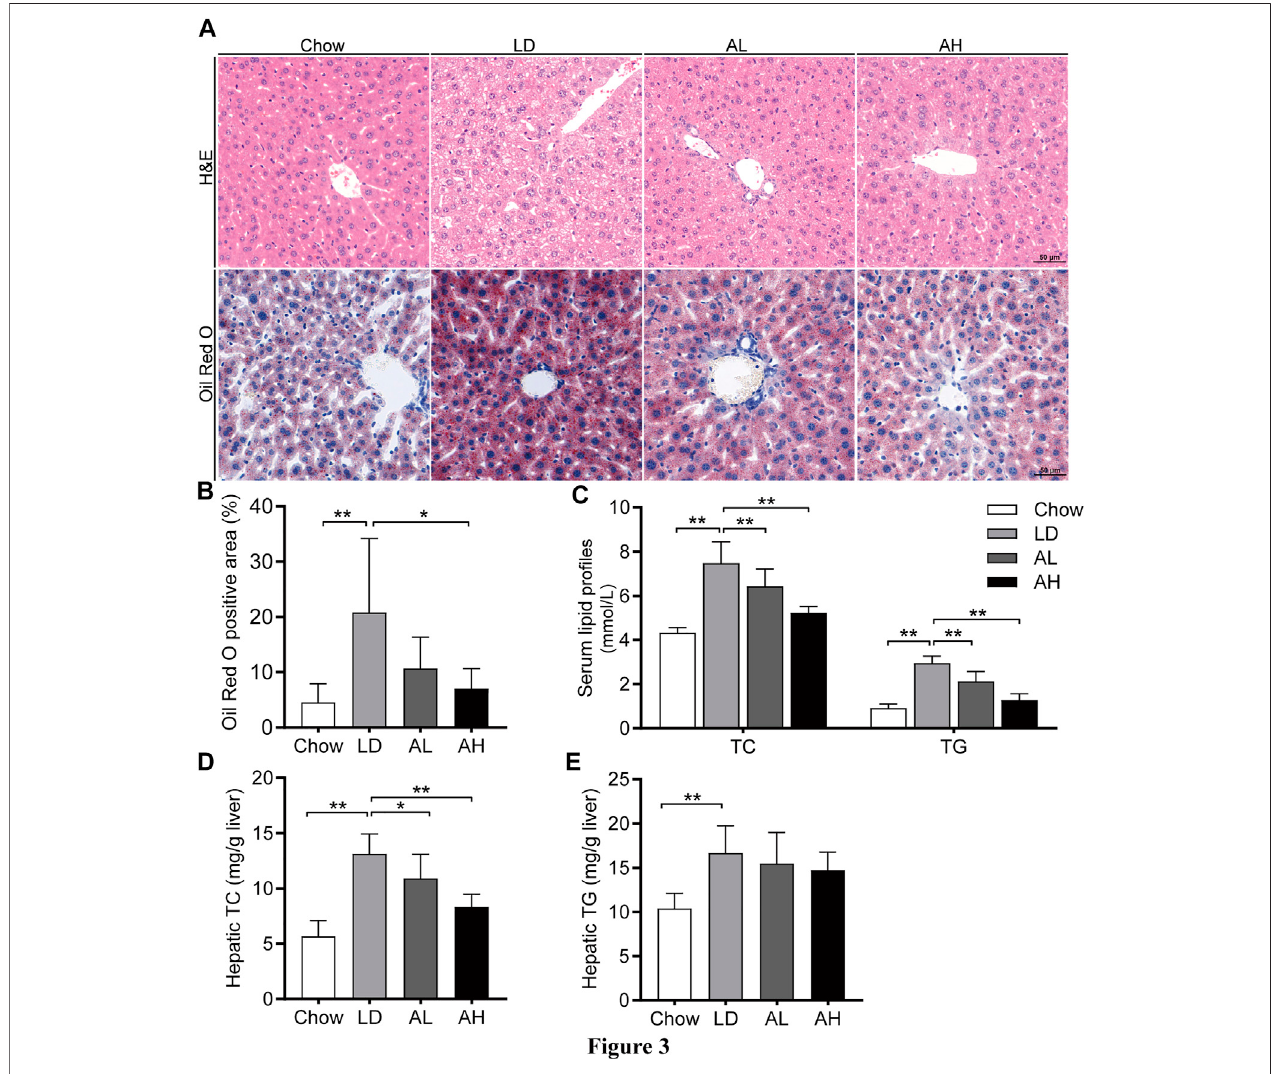
FIGURE 3 | APS attenuated LD-induced metabolic disorders. (A) Representative images of H&E and Oil Red O staining per group (scale bar: 50 μ m). (B) PercentageofOilRedOpositivearea. (C) Serumlevelsoftotalcholesterol(TC)andtriglycerides(TG). (D) HepaticlevelofTC. (E) HepaticlevelofTG.Dataarethemean ± SD ( n (cid:2) 10). * p < 0.05, ** p < 0.01. Chow, chow diet; LD, lithogenic diet; AL, low-dose APS; AH, high-dose